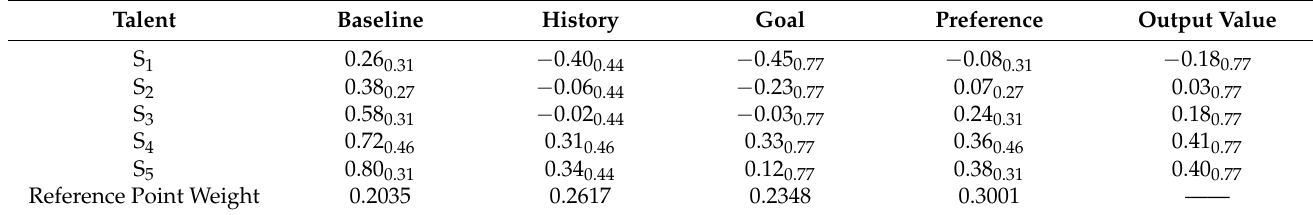
Table 6. Output value and reference point weight under different reference